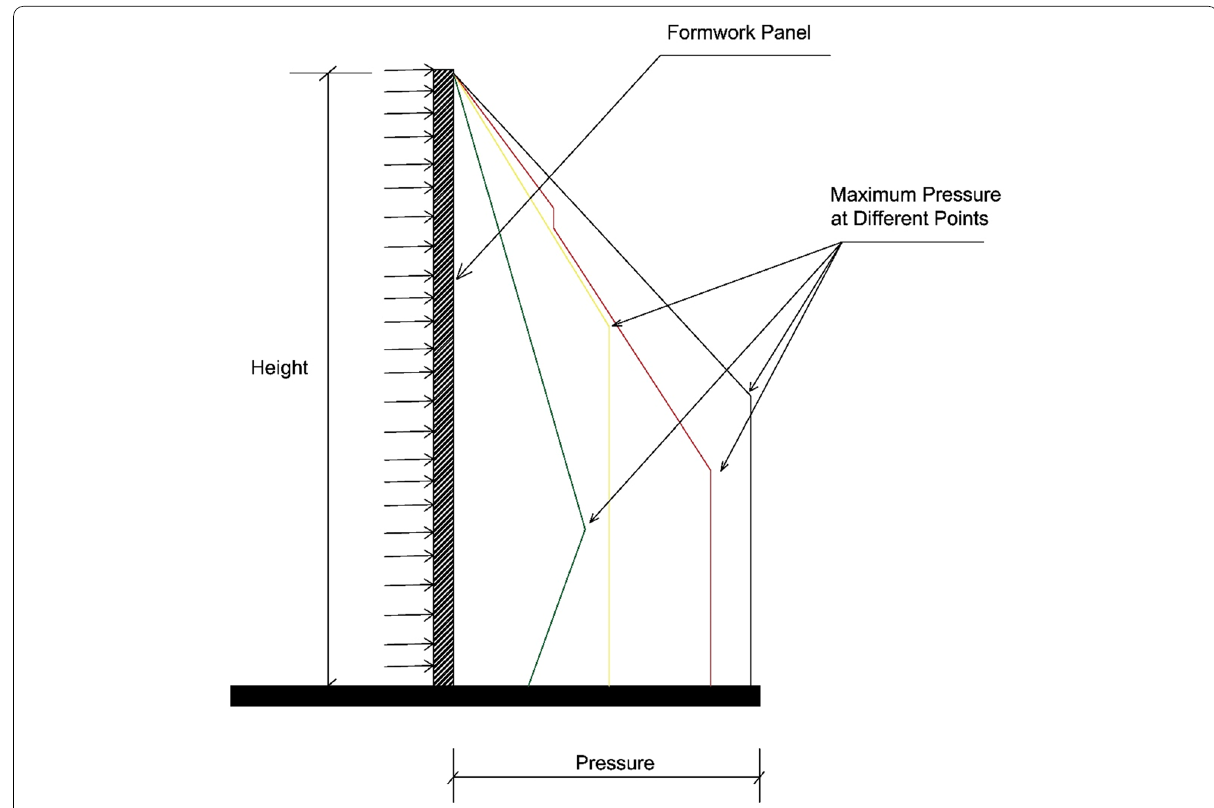
Fig. 6 Lateral pressure exerted on formwork at different points (Puente et al.,